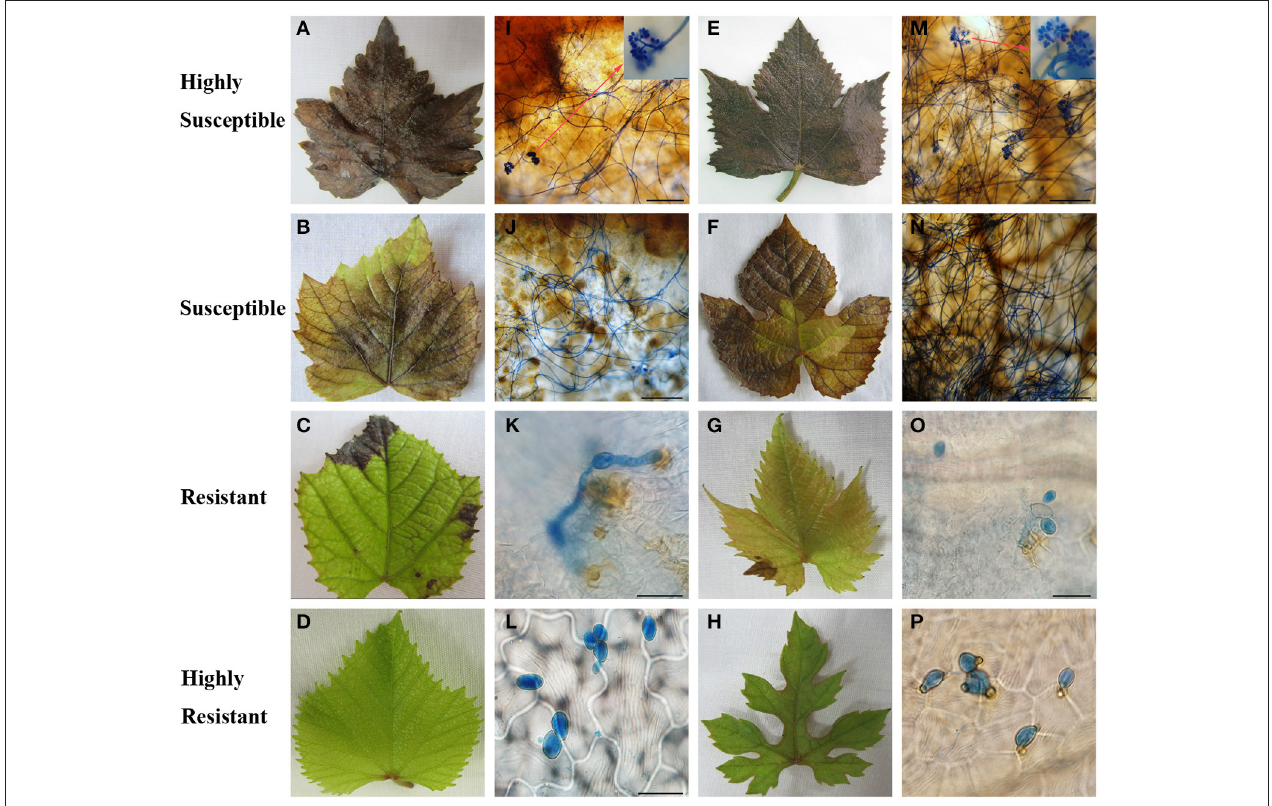
FIGURE 2 | Macroscopic (A–H) and microscopic (I–P) evaluation of two representative Vitis genotypes from each level of B. cinerea resistance, V. amurensis Rupr) are shown in (A,I) and (E,M) , respectively. Red arrows in respectively. Highly susceptible “Red Globe” ( V. Vinifera ) and “Beichun” ( V. Vinifera × (I,M) show new sporulation events at sites indicated. Susceptible V. davidii var. “Zhenan-3” and V. romanetii “Pingli-2” are shown in (B,J) and (F,N) , respectively. V. quinquangularis “83-4-85” and V piasezkii “Gansu-91” represent resistant genotypes and are shown in (C,K) and (G,O) , respectively. V. amurensis “Tonghua-3” and V. sp. (Qinling grape) “Pingli-5” are highly resistant and are shown in (D,L) and (H,P) , respectively. Scale bars: (I,J,M,N) : 50 µ m; (K,L,O,P) : 20 µ m. One